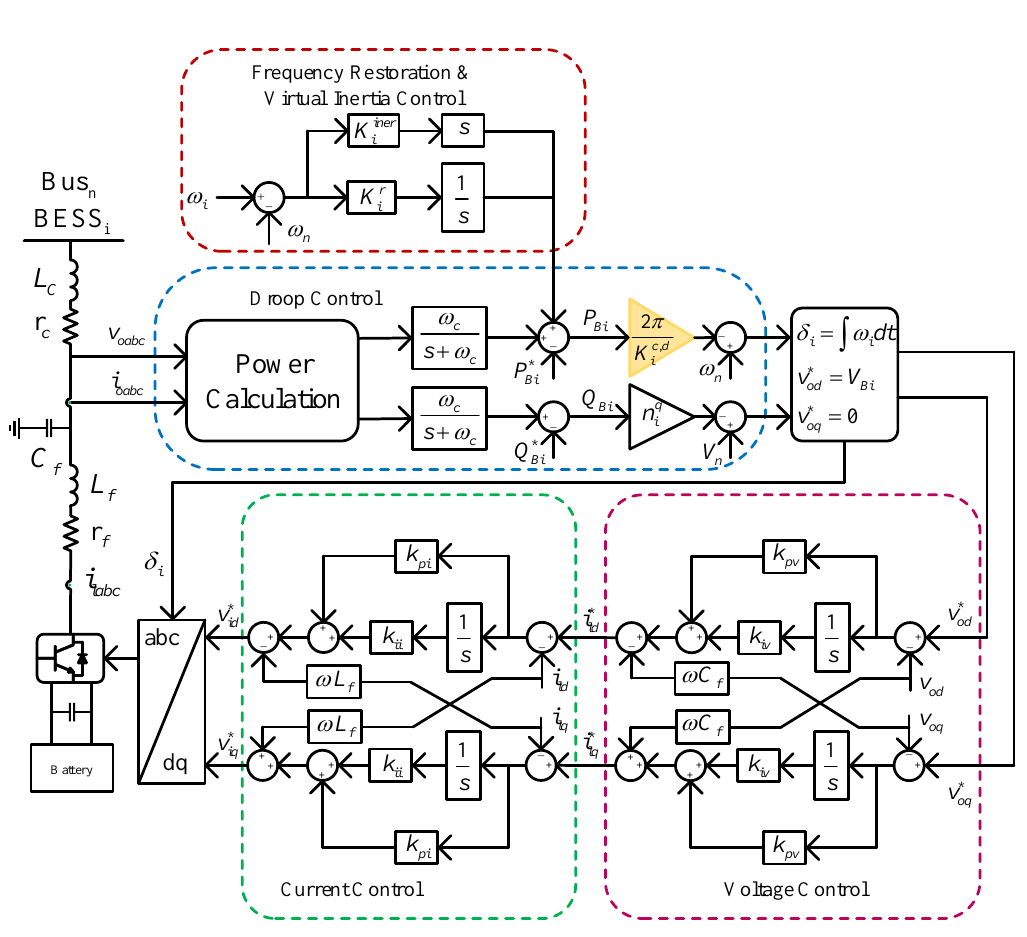
Figure 4. BESS and proposed control